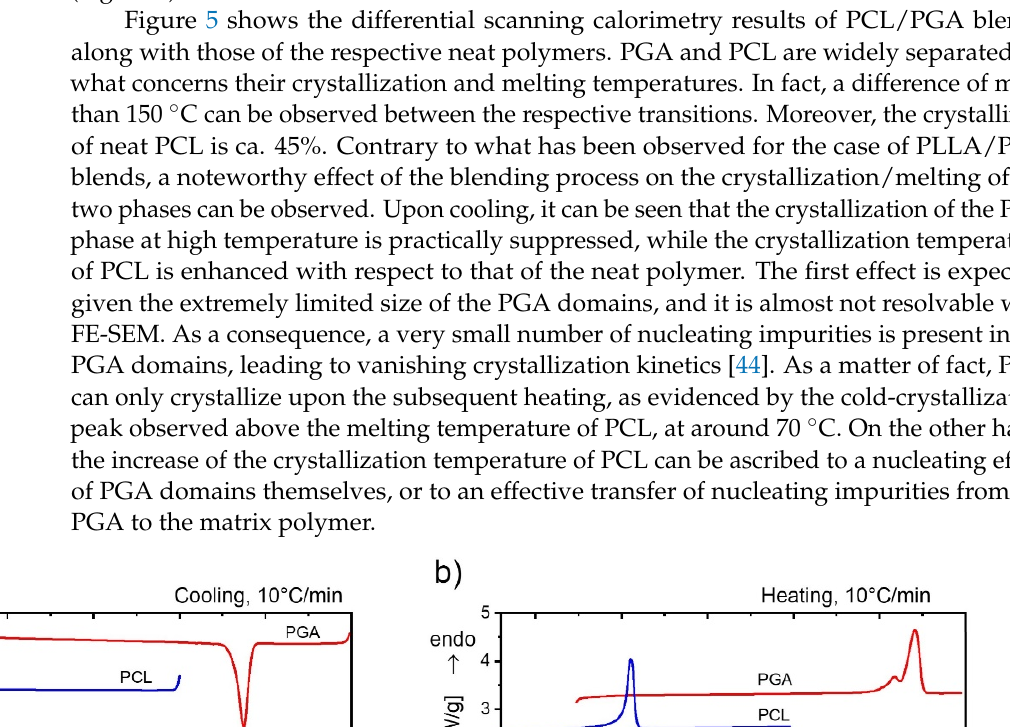
Figure 6. Mass loss versus temperature ( a ) and its derivative ( b ) for neat PLLA, PGA, and their blends at the indicated compositions. Thermogravimetric data for the system PCL/PGA are shown in Figure 7. PCL pos- sesses a higher thermal stability with respect to PGA. In particular, the onset of PCL deg- radation is located approximately 50 °C above that of PGA. In addition, the maximum